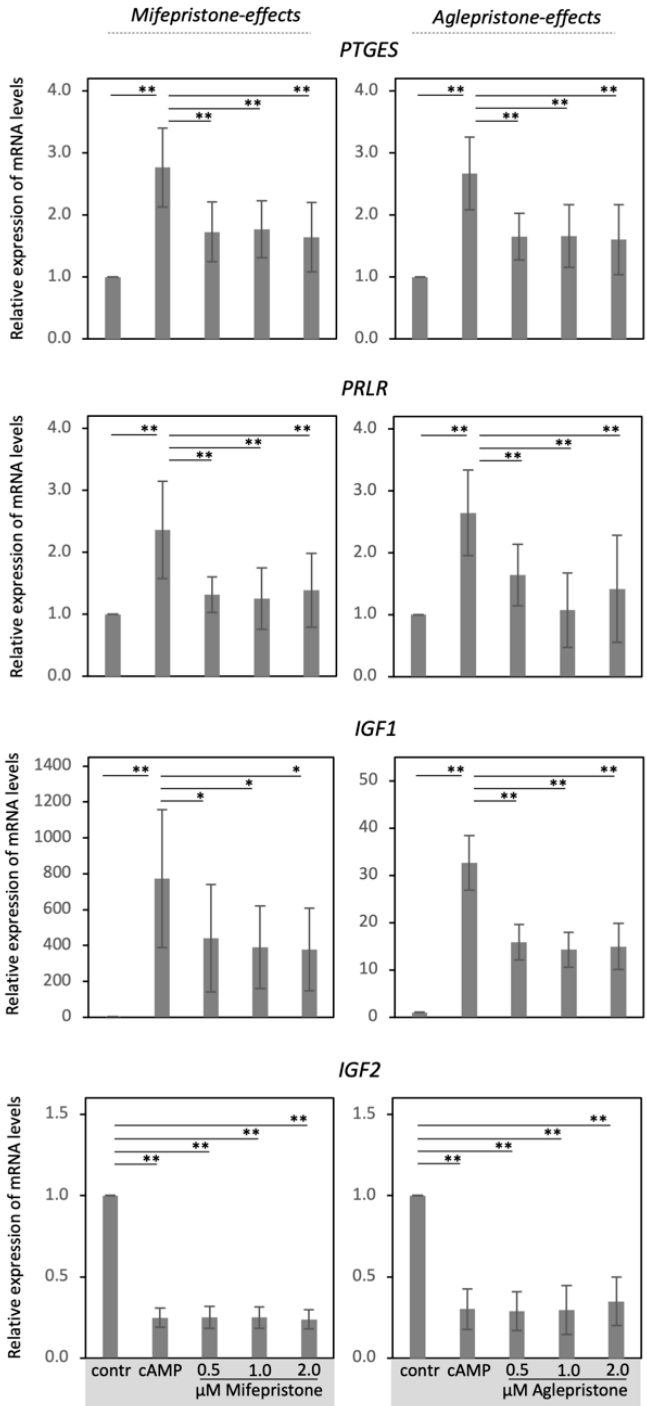
Figure 3. Antigestagen-mediated effects on the expression of decidualization markers in decidualized DUS cells. Relative expression of prostaglandin E2 synthase ( PTGES ), prolactin receptor ( PRLR ), insulin-like growth factor ( IGF )-1, and -2, as determined by semi-quantitative real-time (TaqMan) PCR in DUS cells decidualized with 0.5 mM cAMP for 72 h and consequently treated with increasing dosages of mifepristone or aglepristone for 6 h. Effects of treatments were evaluated with a one-way ANOVA ( p < 0.0001 for all the evaluated factors), followed by a Tukey-Kramer multiple-comparisons test. Numerical data are presented as mean ± standard deviation (SD). Bars with different asterisks differ at: (*) p < 0.01, (**) p < 0.001.